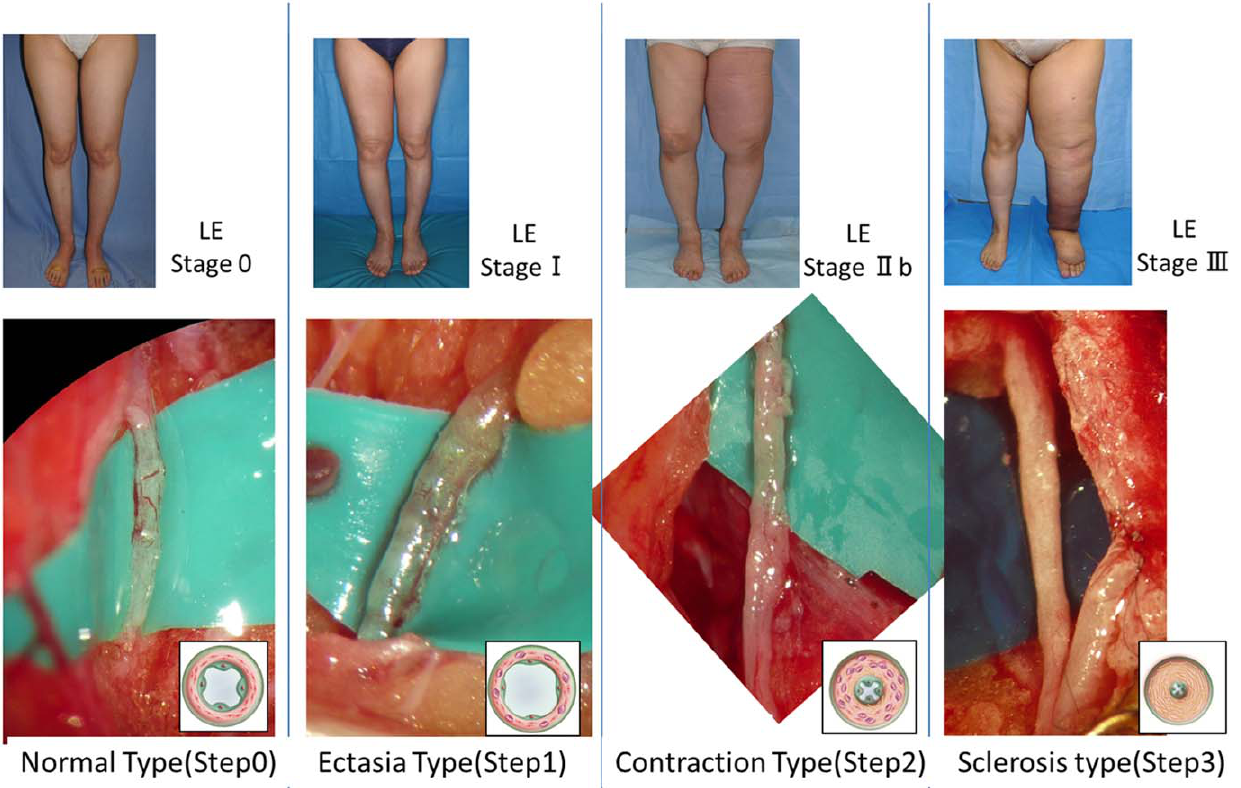
Figure 2. Staging of lymphedema and the macroscopic anatomical findings in the collecting lymphatic vessels associated with the stages. In the normal type, microvascular networks were found to nourish the largely developed walls of the collecting lymphatic vessels. The microvascular networks were gradually lost with the progression of the disease stages. In addition, the lymphatic vessel lumen was found to be dilated in the ectasis type, which was associated with an increase in endolymphatic pressure. Because increases in smooth muscle cells and collagen fibers are the major causes of the cloudiness and thickening of the lymphatic vessel wall, they were found to be prominent in the contraction type and the sclerosis type. LE: lymphedema.